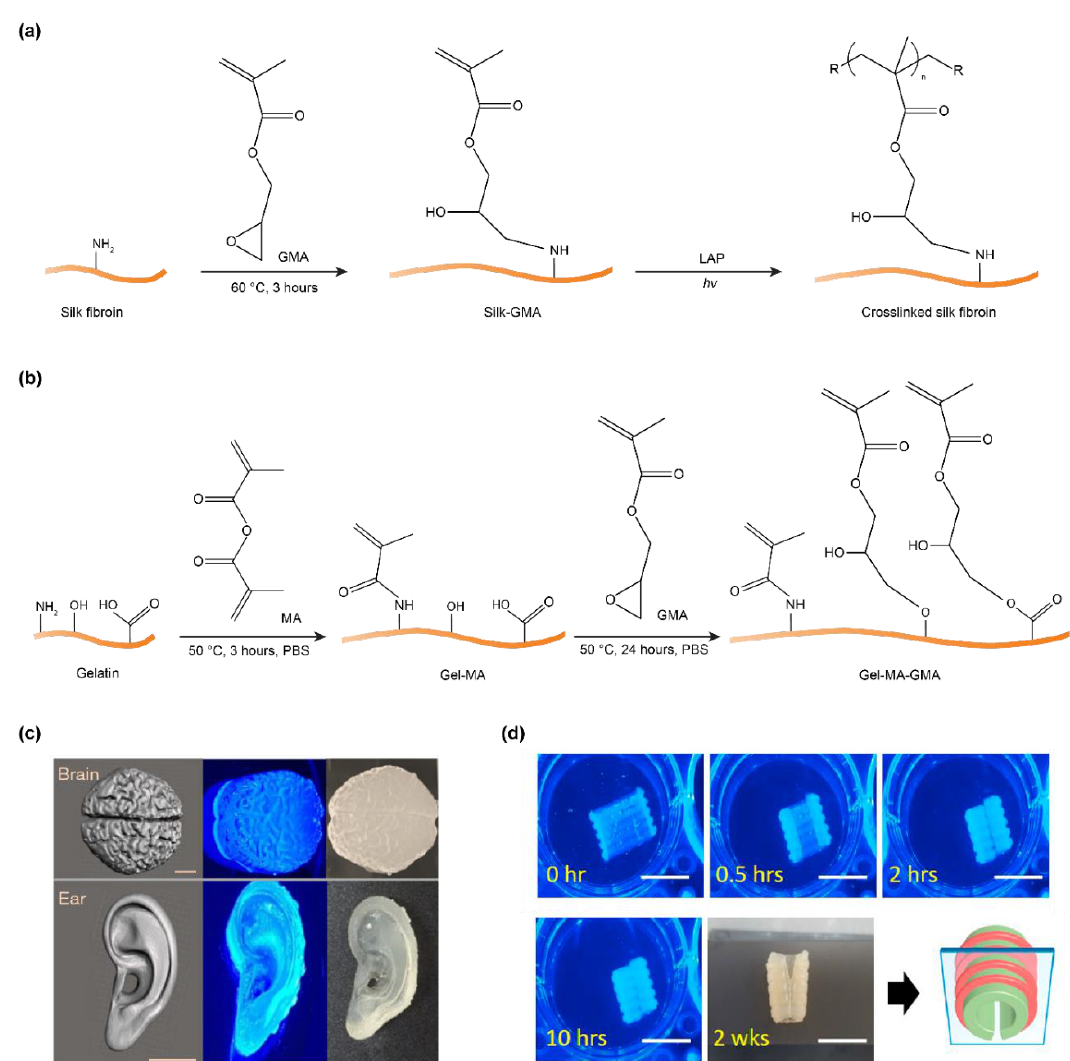
Figure 5 . ( a ) Schematics of methacryloyl-modification of silk fibroin via glycidyl methacrylate (GMA) and photo-crosslinking via lithium acylphosphinate salt (LAP). The illustration shows only one methacryloyl substitution on the amine group for clarity. It is possible to modify the amine group with two methacryloyl substitutions [49]. ( b ) Gelatin was modified with methacryloyl groups at amine, hydroxyl, and carboxyl groups in a two-step manner [104]. ( c ) Three-dimensionally printed brain- and ear-like silk fibroin structures via digital light processing (DLP). Scale bars, 1 cm. Reproduced with permission from Reference [49] under the Creative Commons Attribution License. ( d ) Three-dimensionally printed planar silk fibroin structures that transform into C-shape as a scaffold for repairing the trachea. Scale bars, 1 cm. Reproduced with permission from Reference [80]. Copyright 2020 Elsevier.